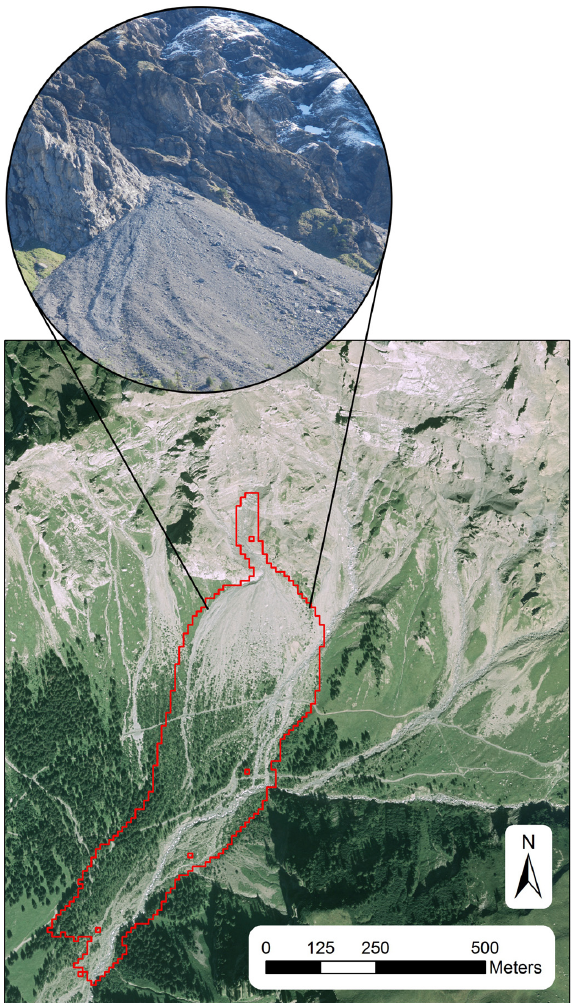
Fig. 9. A fan on the Diablerets Range near Solalex (see location in Fig. 8). The red shape shows the extent of the whole susceptibil- ity zone modeled with Flow-R from a chosen source. Propagation parameters are the same as the case with precision 10 − 4 and 10m DEM in Fig. 11 (Geodata ©swisstopo – DV084371).